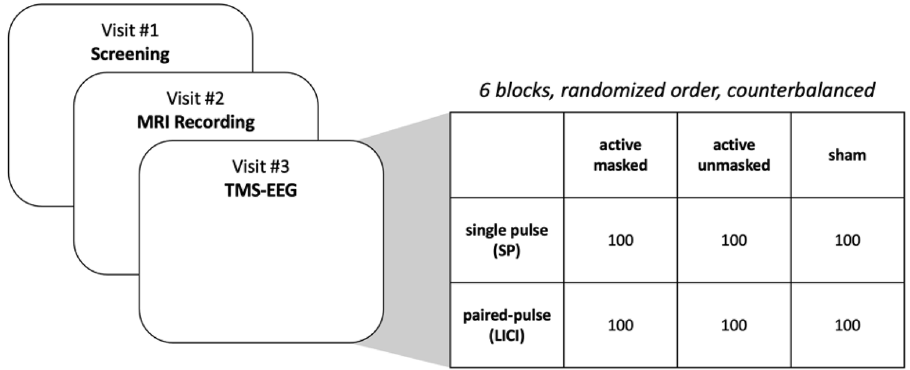
Figure 1. Study design. On the first visit, the participant was screened to meet the inclusion criteria. On the second visit, structural (T1 and T2) magnetic resonance imaging (MRI) scans were performed. On the third visit, the participant received six blocks of stimulation including single-pulse (SP) and long-interval cortical inhibition (LICI) active-masked (with auditory masking and foam spacing), active-unmasked (without auditory masking and foam spacing), and